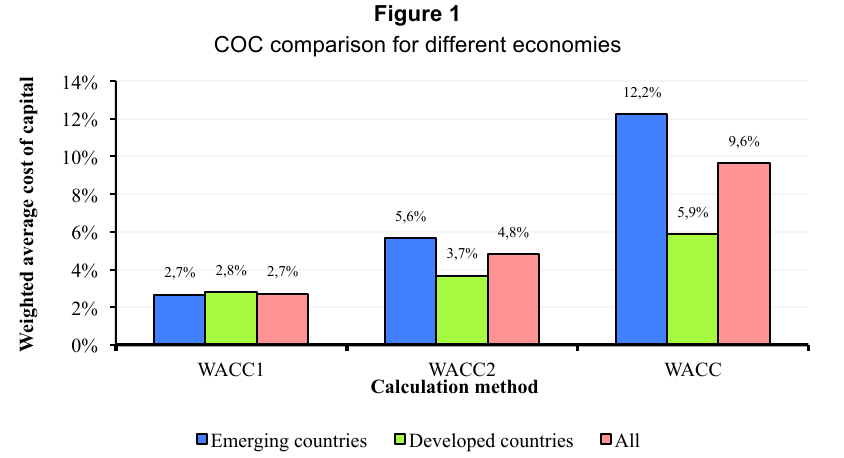
COC comparison for different